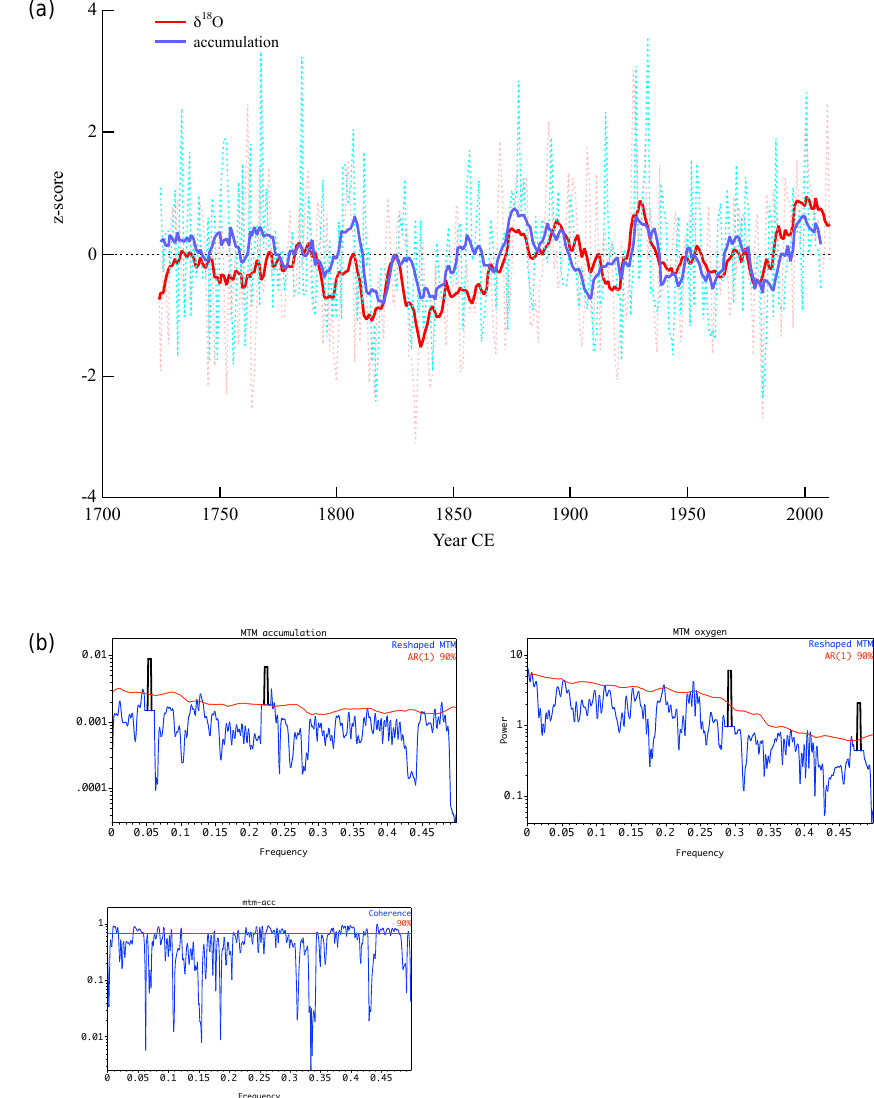
Figure 3. (a) Comparison of z scores of accumulation (blue) and δ 18 O (red) (dashed lines: annual values; thick solid lines: 11-year-average values). Power spectrum of accumulation (b) , δ 18 O (c) and coherency (d) calculated using the multitaper method (resolution of 2, three tapers, adaptative spectrum in blue, tested against compatible white- or red-noise processes shown here in red at 90% confidence level). Harmonic signals (spikes in the spectrum corresponding to a periodic or quasi-periodic signal in frequency, amplitude and phase) are shown with a black